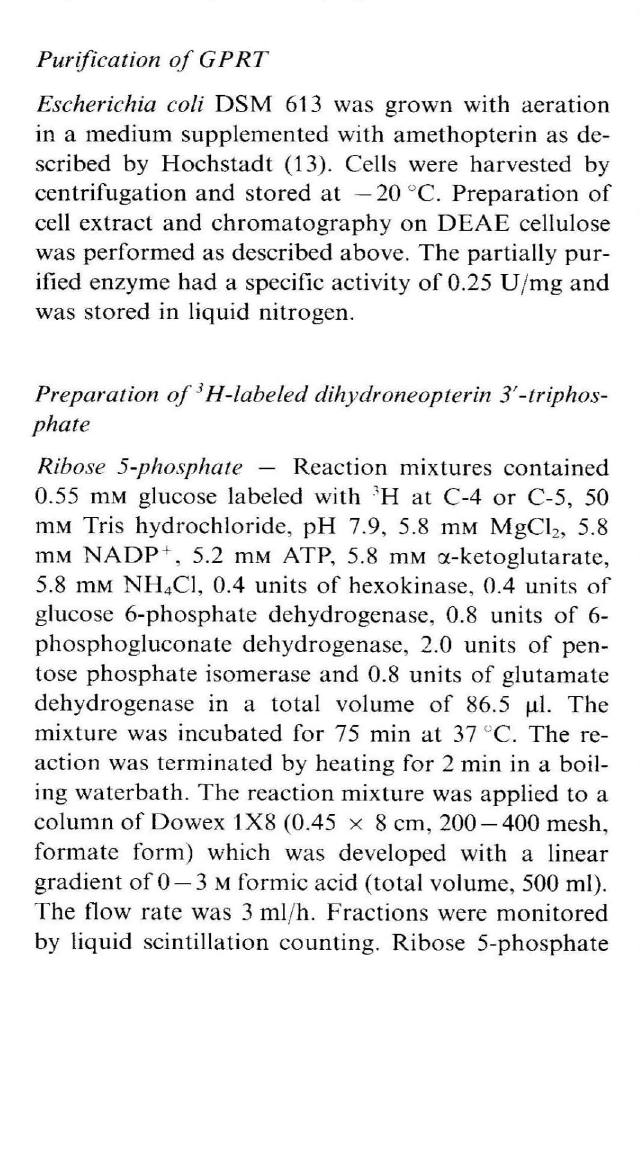
GMP - The reaction mixture contained 3H-labeled ribose 5-phosphate from the previous step, 40 mM phosphate, pH 7.5, 4.7 mM MgS0 4, 0.52 mM